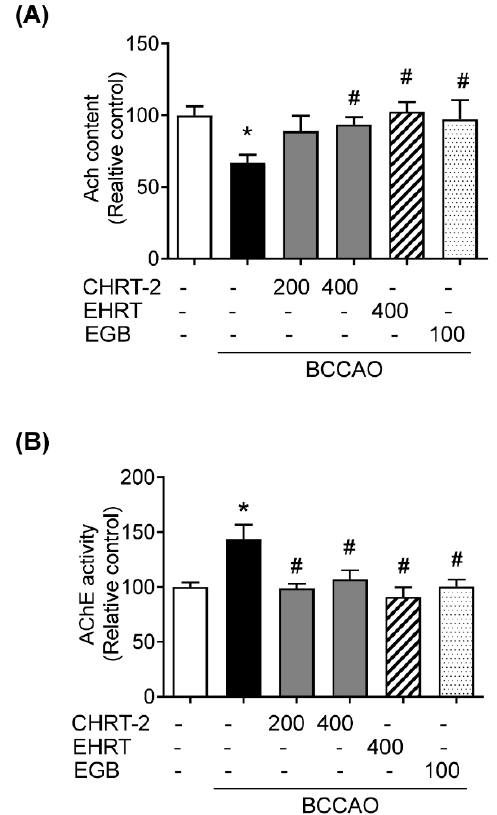
Figure 4. Effect of HRT on cholinergic system dysfunction in BCCAO-induced VaD rats. Acetylcholine (ACh) content ( A ) and AChE activity ( B ) were measured using an ACh and AChE activity assay kit (US Biomax Inc., Derwood, MD, USA). Data are presented as means ± SEM ( n = 8); ** p < 0.01 vs. normal group, # p < 0.01 vs, BCCAO group